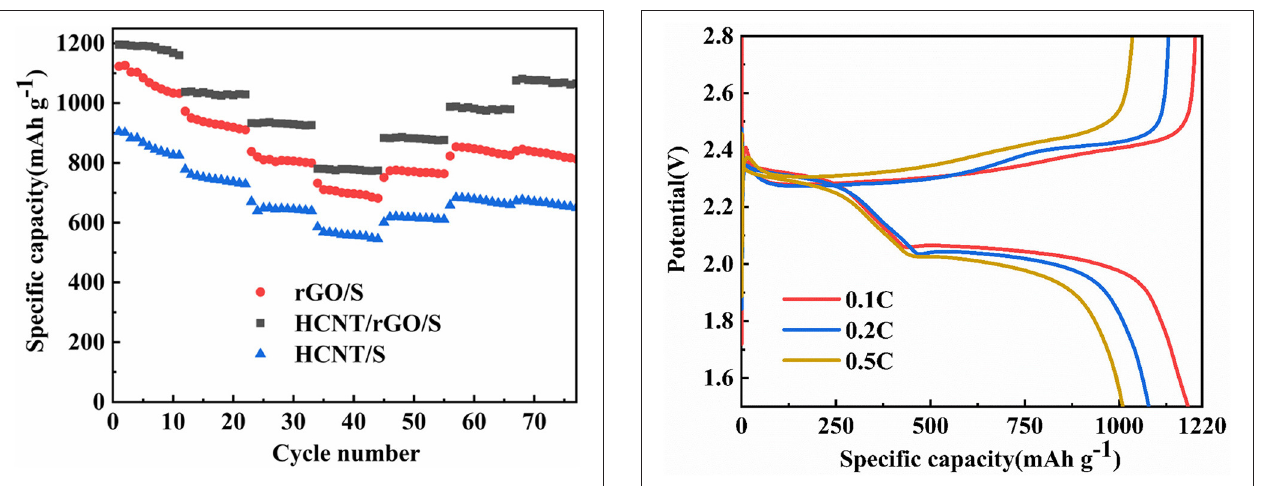
FIGURE 8 | The initial discharge/charge curves of the helical carbon nanotubes (HCNT)/reduced graphene oxide (rGO)/sulfur (S) cathode at various C rates from 0.1 to